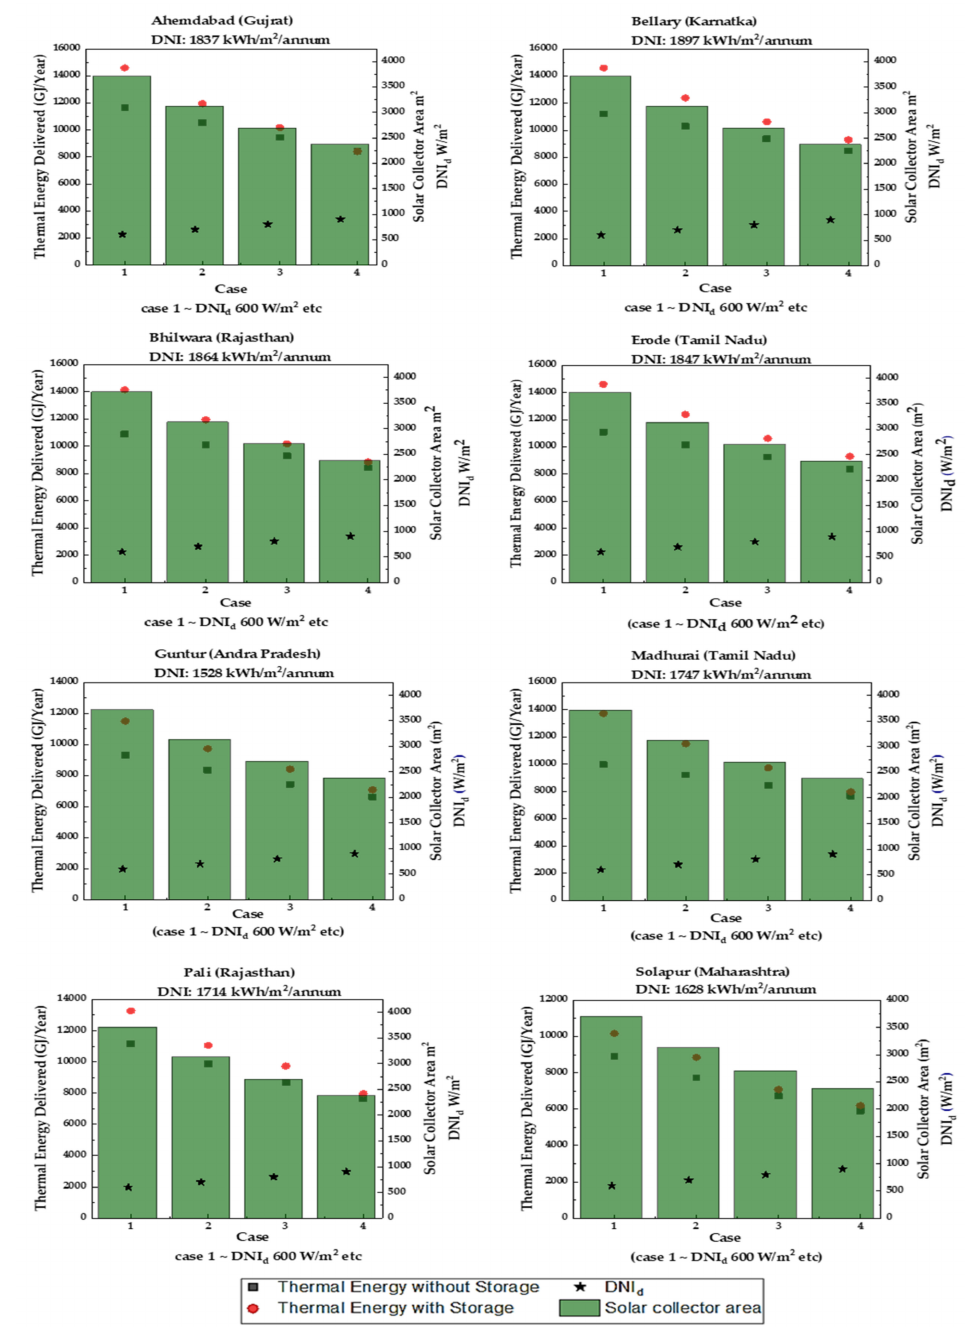
Figure 4. Performance of parabolic-trough-based SIPH for the selected